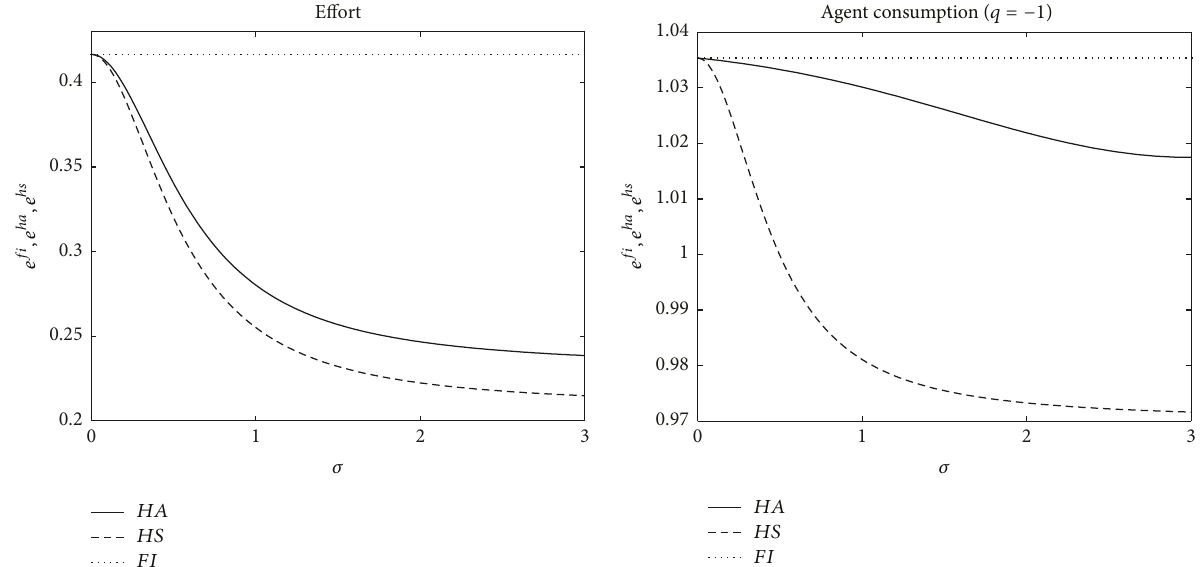
Figure 1: The agent’s effort and consumption policies for different shock level 𝜎 .